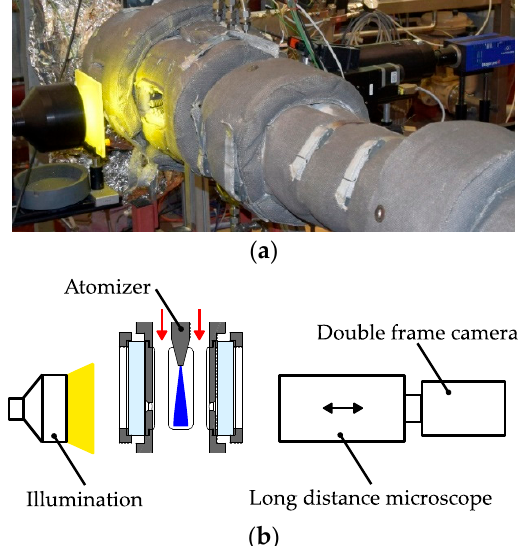
Figure 1. ( a ) Picture of the experimental setup for investigation of urea-water sprays under high temperature and pressure conditions and ( b ) the schematic of the test section and the utilized diagnostics adapted from [17].